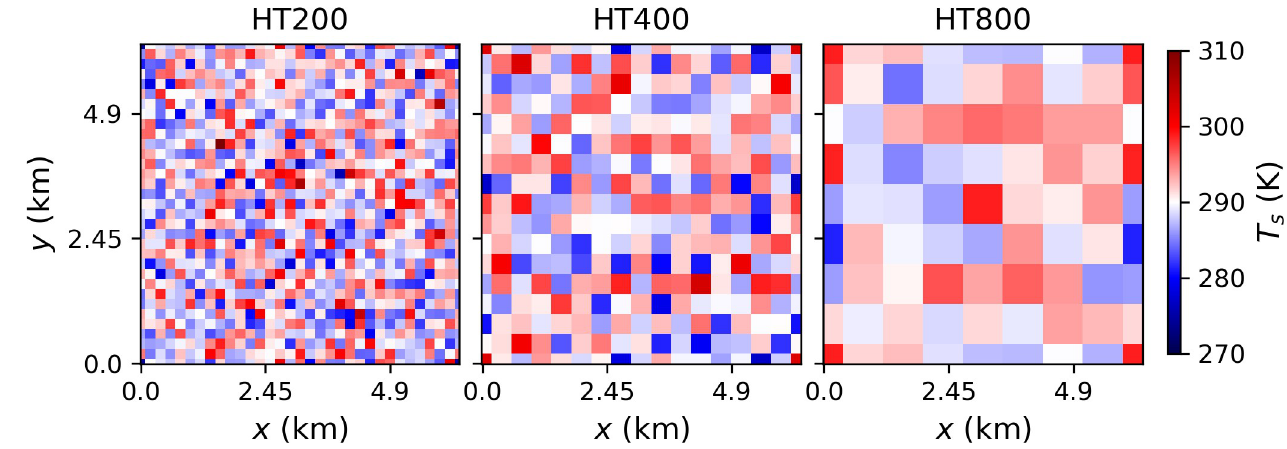
Fig 1. Temperature distribution at the surface for the three sets of simulations with heterogeneous surfaces.